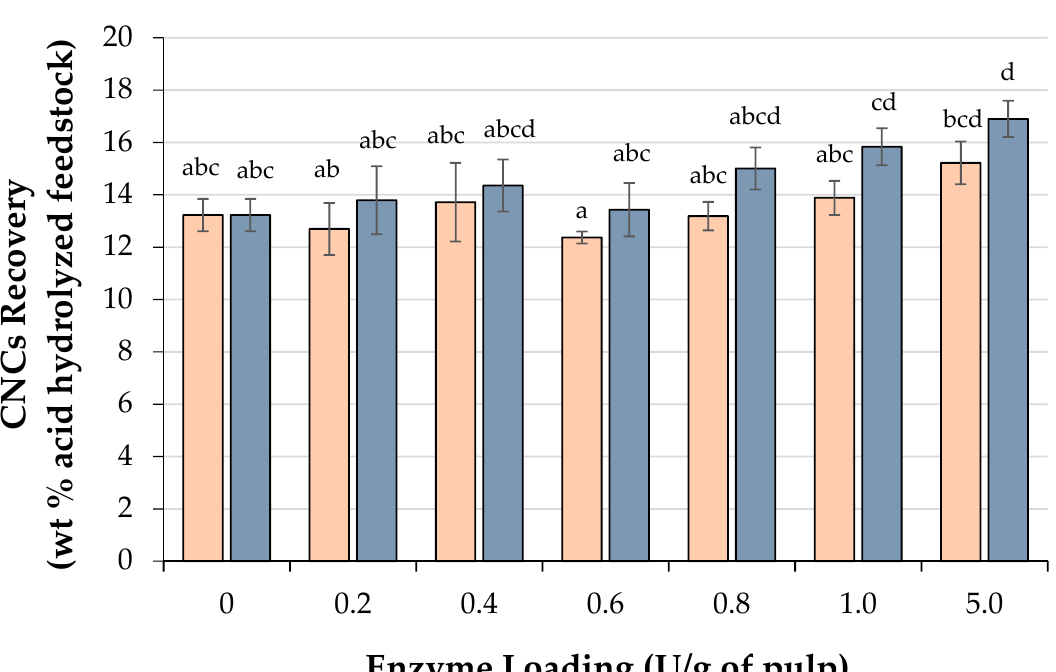
Figure 2. Cellulose nanocrystals (CNCs) recovered following acid hydrolysis of untreated wood pulp or the solid residue remaining after treatment with various amounts of endoglucanase with (Endo-CBD+) or without (Endo-CBD − ) a cellulose-binding domain. CNC yields were determined by dividing the mass of CNCs obtained by the mass of the material subjected to acid hydrolysis (8 g). Columns labelled with different letters indicate means that are statistically different at a 95% confidence level.